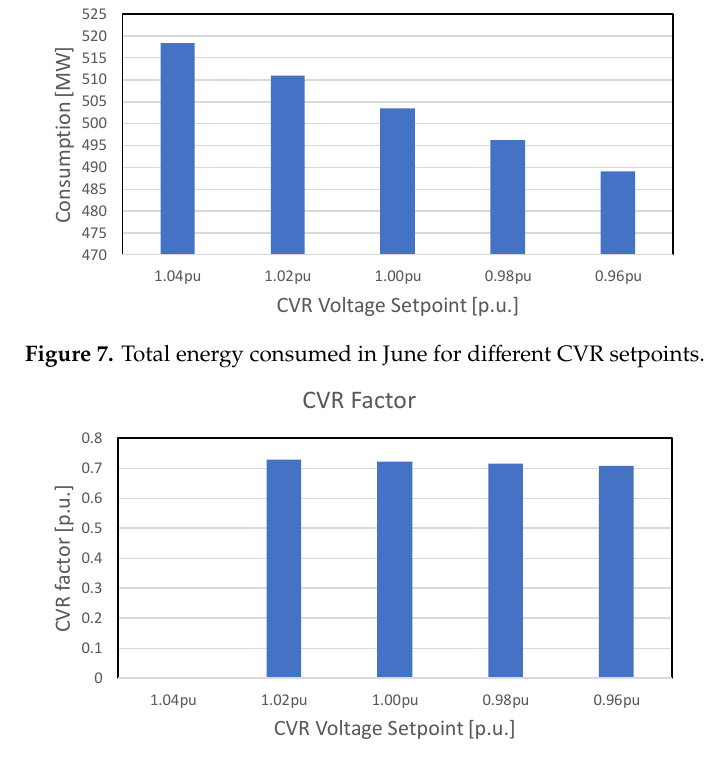
Figure 8. CVR Factor in June for different setpoints.